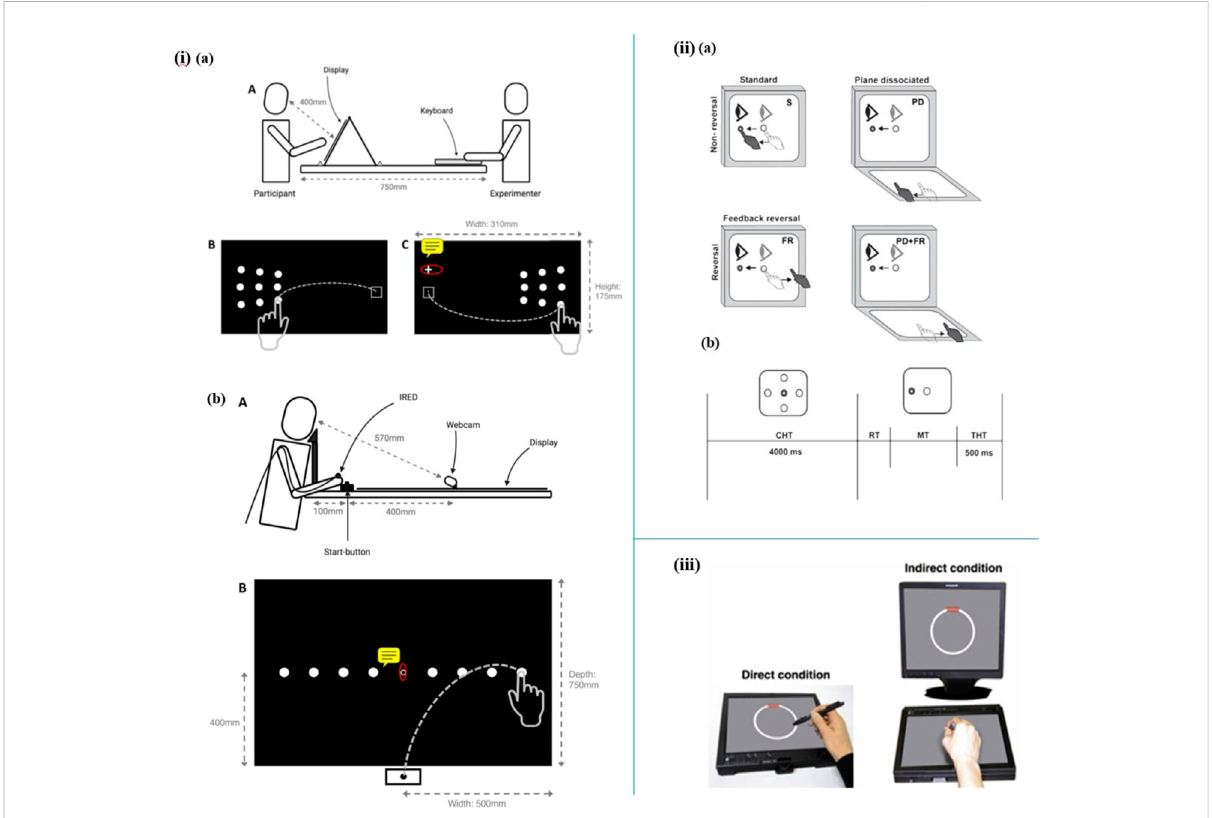
FIGURE 6 i) (A) Schematic diagram of lateral reaching task. (B) Schematic diagram of radial reaching task (Mitchell, Rossit, Pal, Hornberger, Warman, Kenning,Williamson,Shapland,McIntosh).ii) (A) Schematicdiagramillustratingthefourexperimentalconditions. (B)